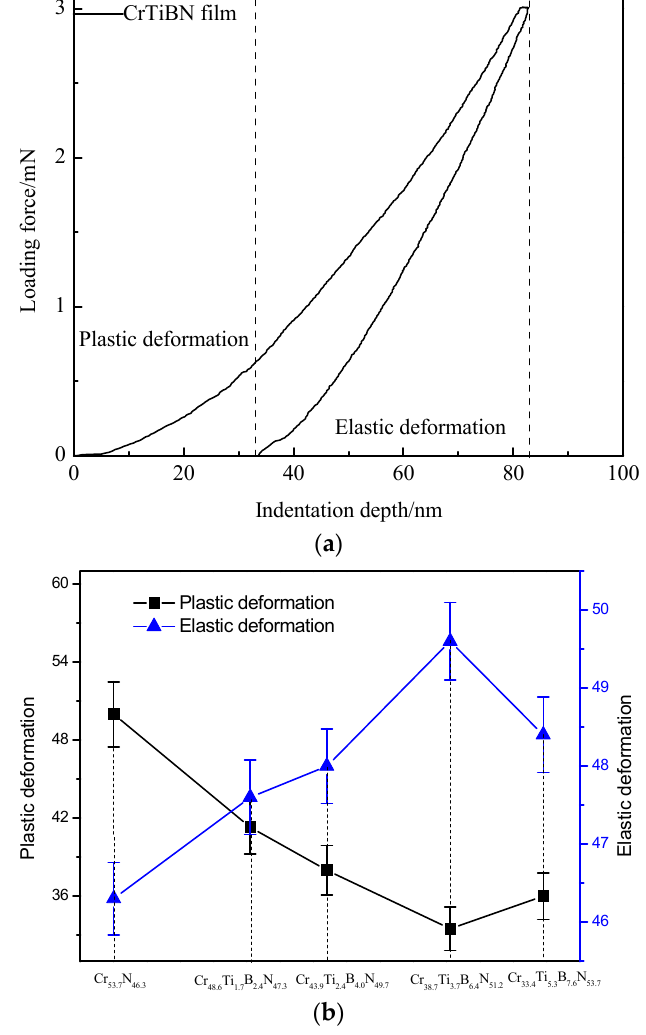
Figure 6. ( a ) Curves of nanoindention of Cr 38.7 Ti 3.7 B 6.4 N 51.2 film; ( b ) amount of Plastic deformation and Elastic deformation of Cr ‐ Ti ‐ B ‐ N films.